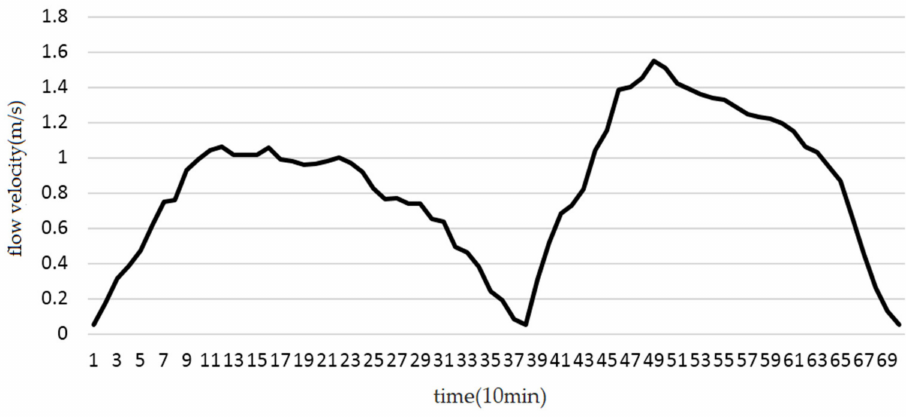
Figure 10. A tidal current periodic velocity in the applied sea area.